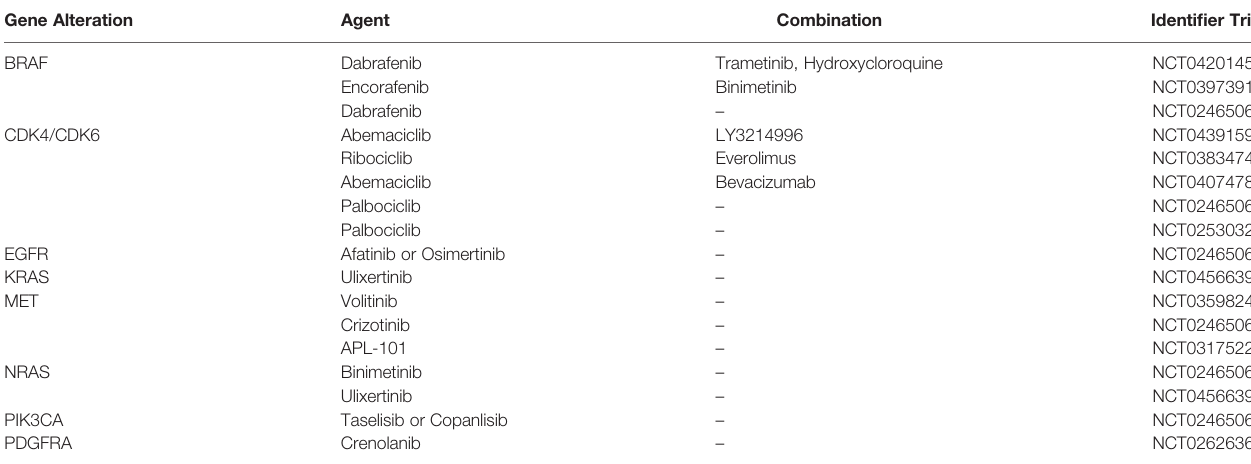
TABLE 2 | Active clinical trials for the targeted treatment of malignant